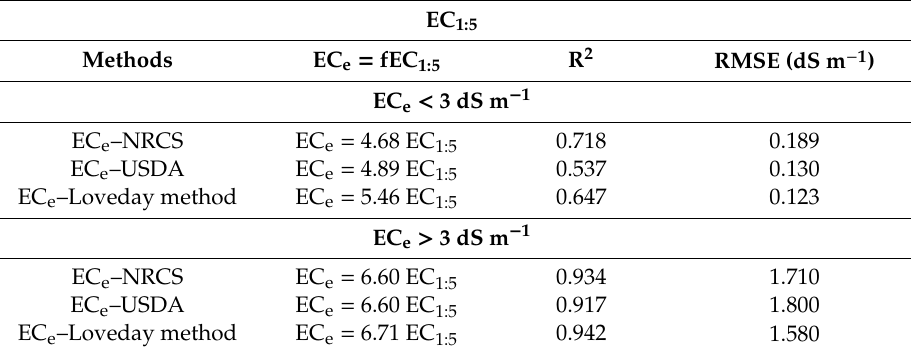
Table 5. Regression equations describing the relation between saturated paste extracts EC e and EC 1:5 determined by three di ff erent methods with the coe ffi cients of determination (R 2 ) and root mean square errors (RMSE) for all soil examined for EC e < 3 dS m − 1 and EC e > 3 dS m − 1